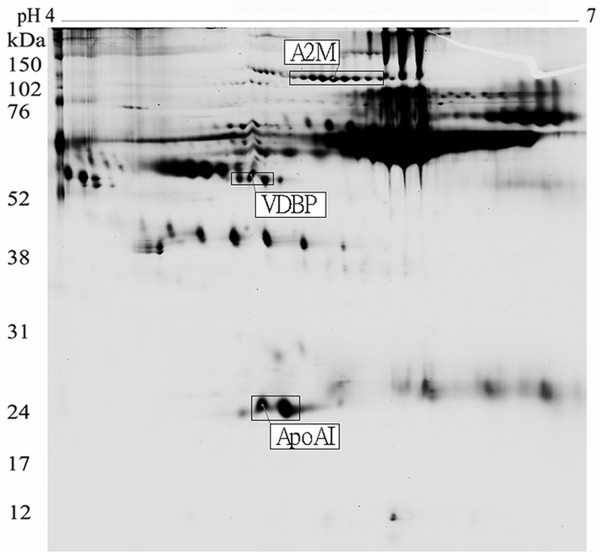
Three novel biomarkers of liver fibrosis, A2M, VDBP and ApoAI, appear on the location of 162 kDa, 52 kDa and 28 kDa in the 2D-DIGE gels. Observably there are several adjacent spots near A2M, VDBP and ApoAI protein; the adjacent spots were identified as same as A2M, VDBP or ApoAI respectively.